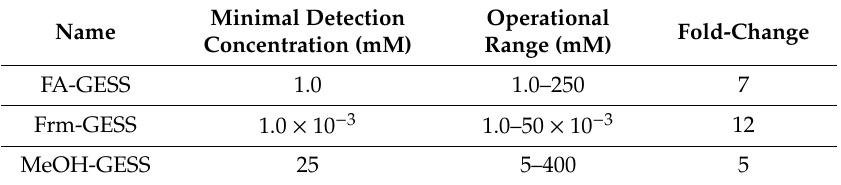
Characteristics of the C1 biosensors in response to formate, formaldehyde, and methanol